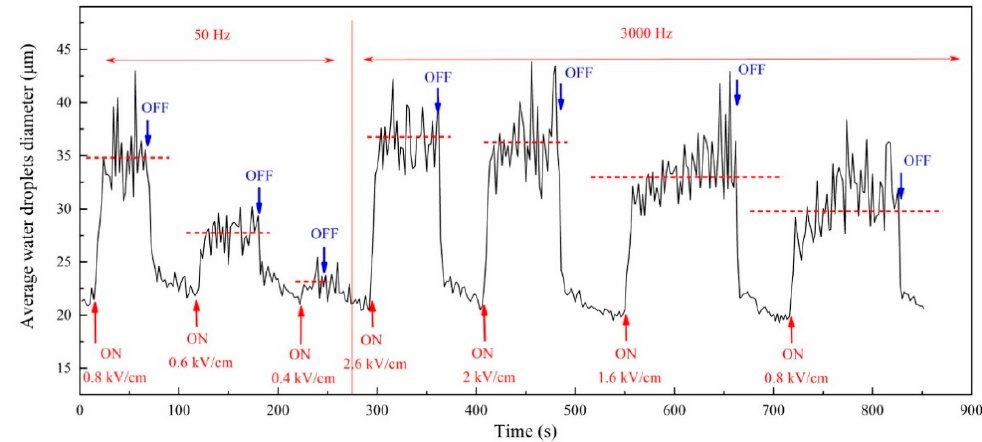
Figure 19. Variations of average water droplet size under different electric field parameters (water content 30%).